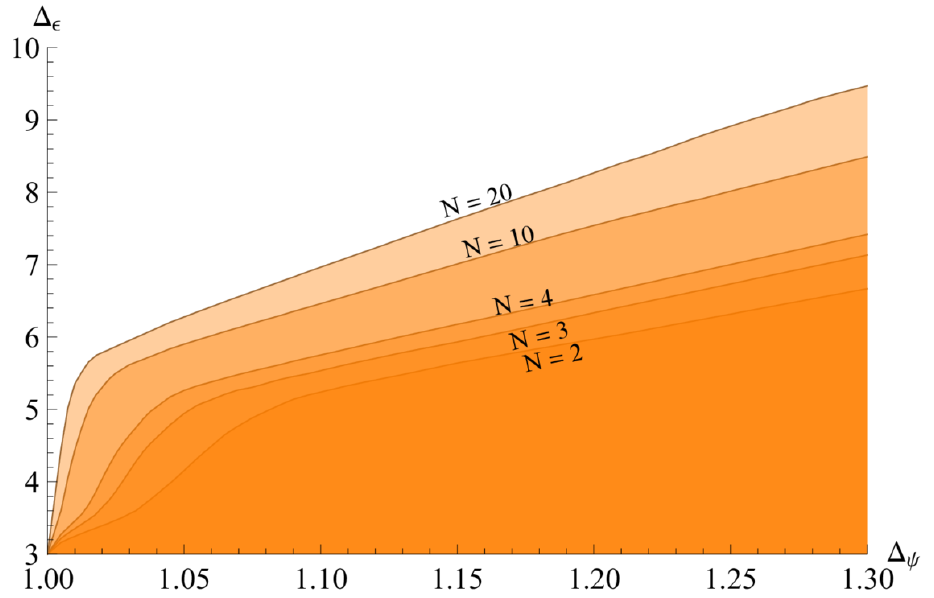
Figure 4 . Upper bounds on the scaling dimension of the lowest-lying parity-even O ( N ) singlet, (cid:1) (cid:15) , for a unitary CFT containing fermions with scaling dimension (cid:1) . Once again, we focus